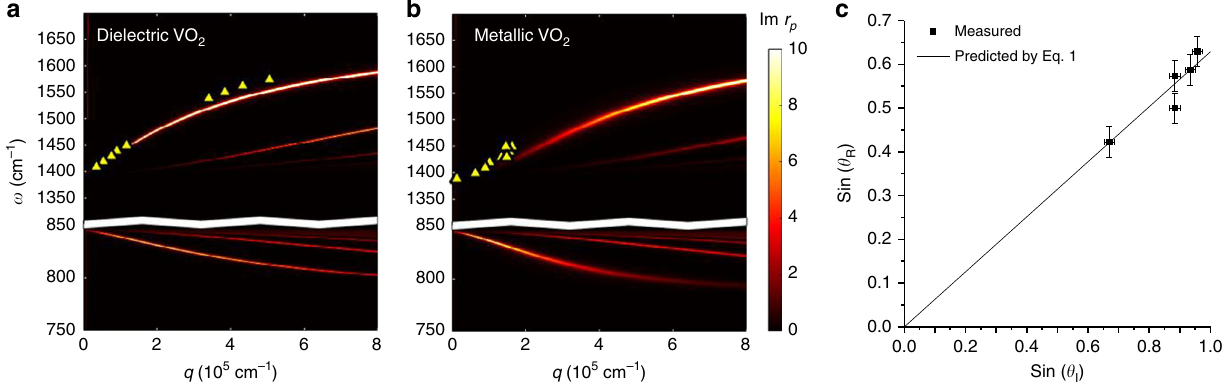
Fig. 3 Hyperbolic polariton dispersion in hBN over both dielectric ( a ) and metallic ( b ) domains of VO 2 compared with numerical calculations. The horizontal white line shown in a and b indicates a break in the graph, between upper (1394 – 1650 cm − 1 ) and lower (785 – 845 cm − 1 ) Reststrahlen bands. From the measured dispersion, the angle of refracted waves at 1450cm − 1 can be computed for a given incident angle and compared against experimentally measured results in c . There has been no fi tting in this result. The x and y error bars in c represent the SD of measurements of incident (±1°) and